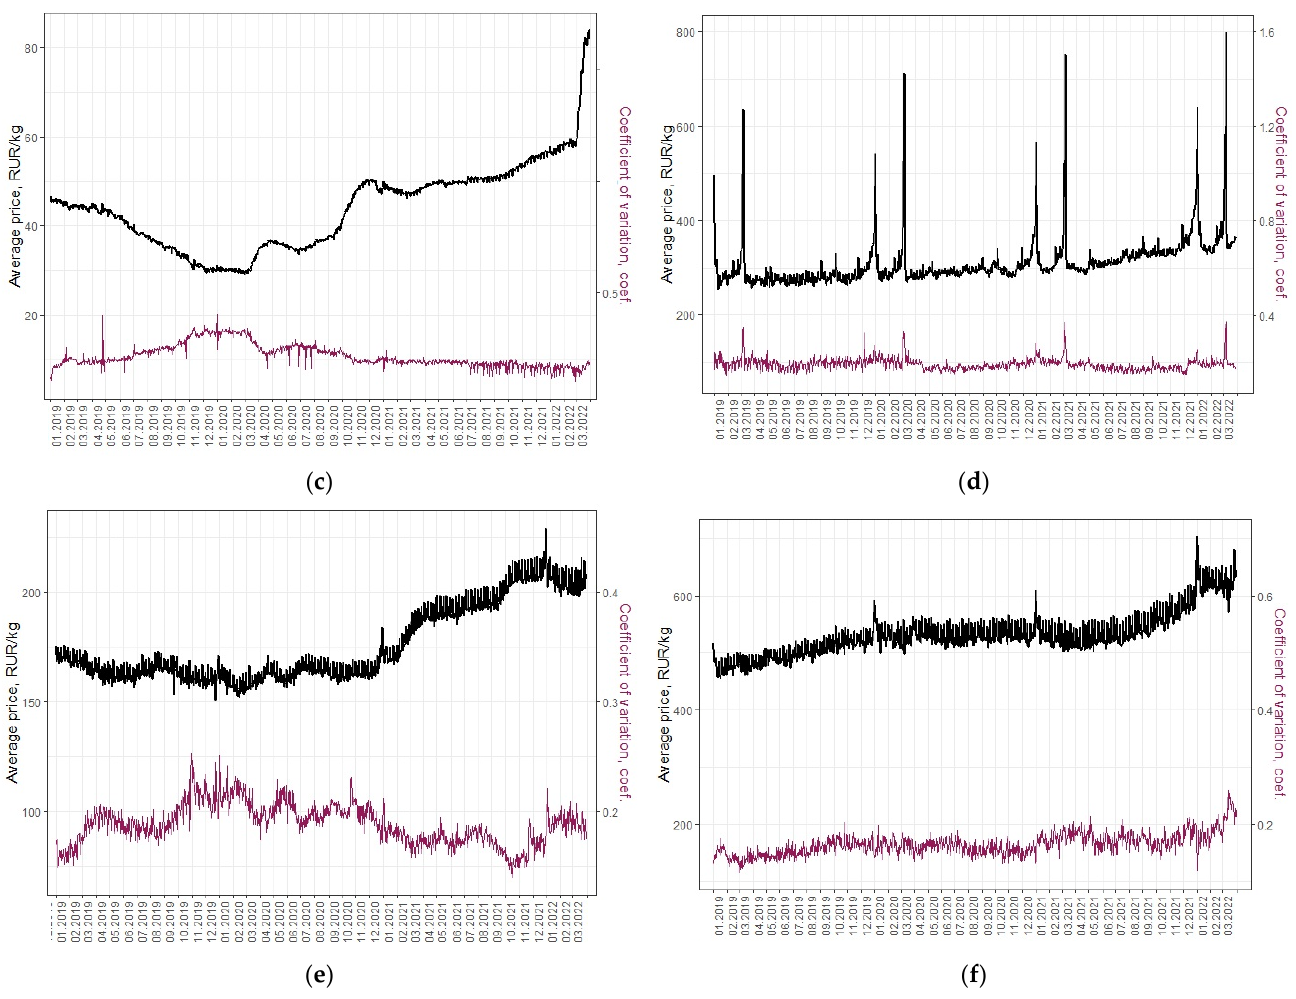
Figure 1. Daily average regional price of Pasta ( a ), Potatoes ( b ), Sugar ( c ), Candies ( d ), Poultry meat ( e ), Butter ( f ) and respective coefficients of variation from 1 January 2019 to 31 March 2022.